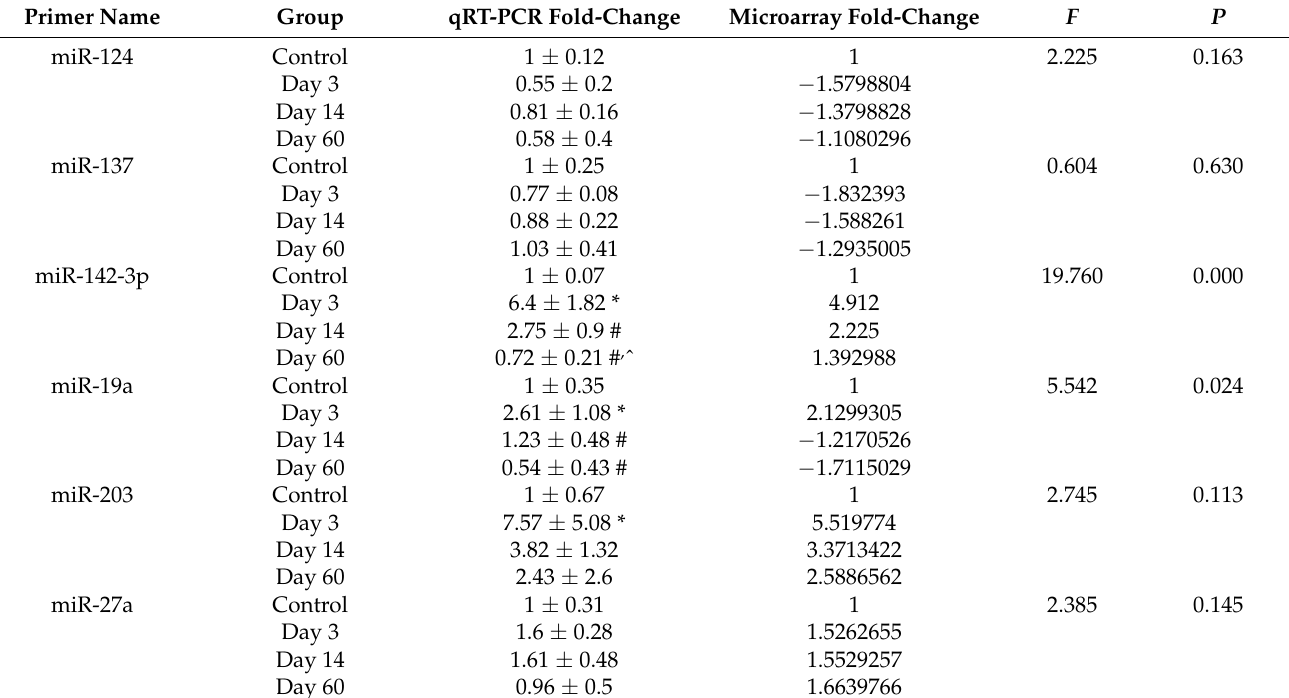
Table 2. Validation of microarray results in the DG area by